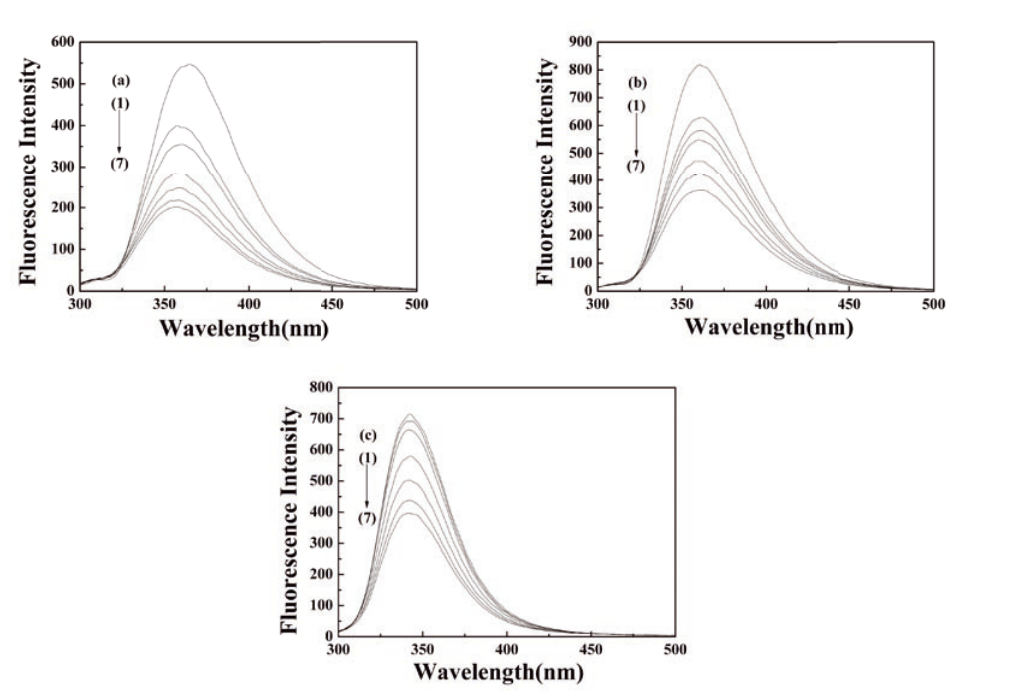
Figure 2. Fluorescence spectra of the combination HL 1 (a), HL 2 (b) and HL 3 (c) in the absence and presence of increasing amounts DNA, = 280 nm, λ = 300 – 500 nm. Arrows show the intensity changes upon increasing concentration of the DNA. λ ex em For(a) [HL 1 ]=40 μmol L -1 , [DNA]/10 -5 mol L -1 : (1): 0; (2): 1.8; (3): 3.6; (4): 5.4; (5): 7.2; (6): 9.0; (7): 10.8. For(b) [HL 2 ]=40 μmol L -1 , [DNA]/10 -5 mol L -1 : (1): 0; (2): 1.8; (3): 3.6; (4): 5.4; (5): 7.2; (6): 9.0; (7):10.8. For(c) [HL 3 ]=40 μmol L -1 , [DNA]/10 -5 mol L -1 : (1): 0; (2): 1.8; (3): 3.6; (4): 5.4; (5): 7.2; (6): 9.0;